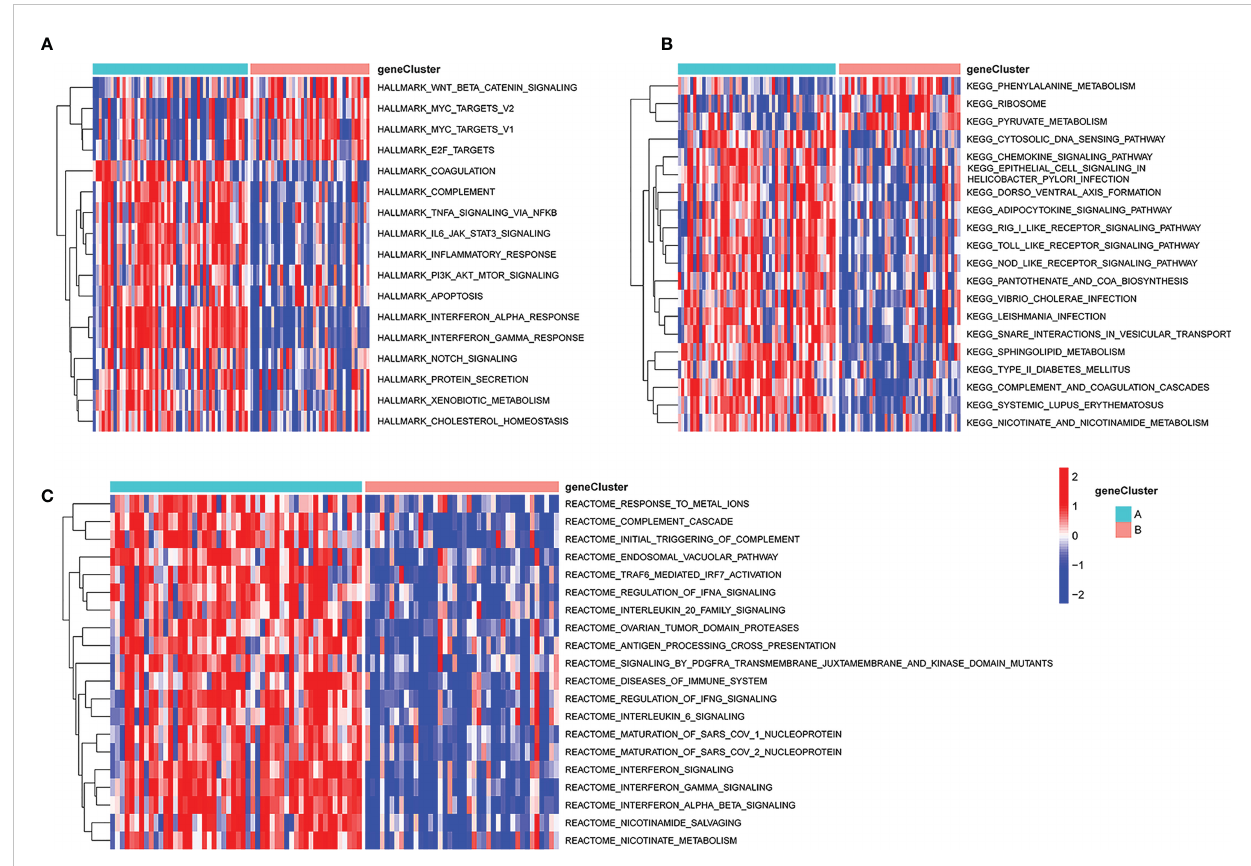
FIGURE 10 GSVA analysis of key pathways in different PCD-related patient subgroups. (A) HALLMARK pathway enrichment results. (B) KEGG pathway enrichment results. (C) Reactome pathway enrichment results. GSVA, gene set variation